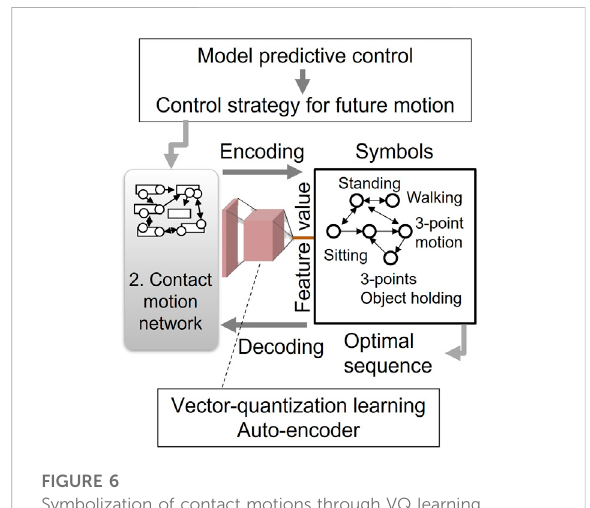
FIGURE 6 Symbolization of contact motions through VQ learning. Control strategies that are obtained from the network by model predictive control are encoded into high-level symbols. The optimal contact sequence for a given goal state is automatically synthesized using the symbols and decoded back to a whole-body contact